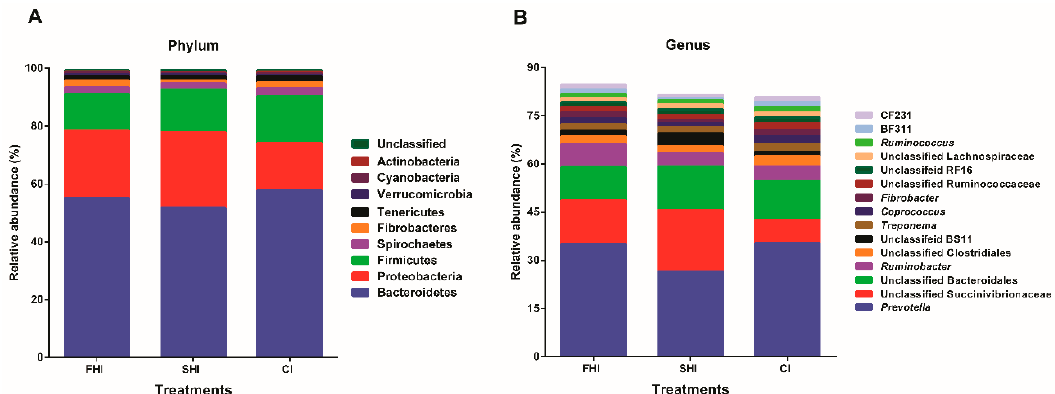
Figure 4. Effect of varying degree of synchronization on changes of microbial taxa. A , Relative abundance > 1% in phyla level. B , Top 15 (relative abundance) genera. FHI, first half infusion of maltodextrin; SHI, second half infusion of maltodextrin; CI, continuous infusion of maltodextrin.